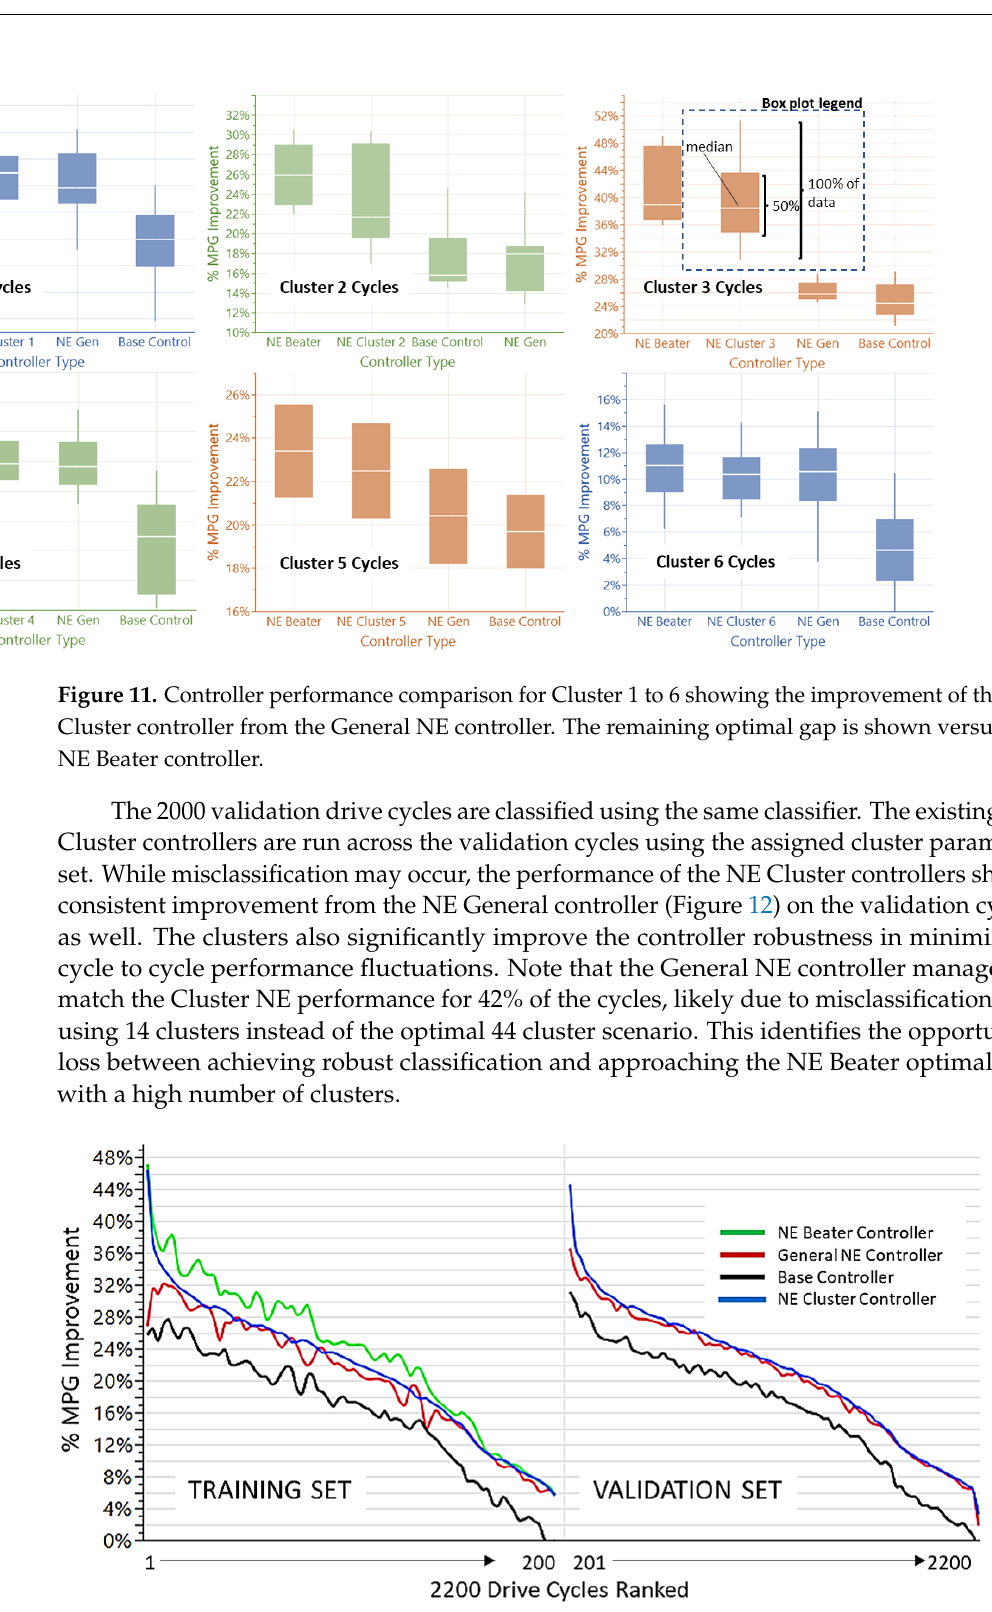
Figure 12. The Classification of each drive cycle and subsequent uploading of updated NE Controller parameters enable sustained and more robust MPG improvement (from the base conventional van) than the General NE controller by